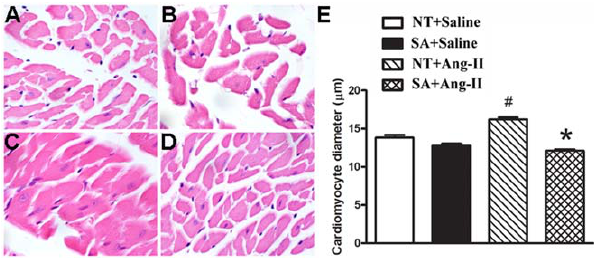
Figure 2. Brain-targeted ACE2 over expression prevents the increase in cardiomyocyte diameters following Ang II infusion. Mice were anesthetized and hearts were processed for H&E staining at the end of 2 weeks Ang II or saline infusion. The average cardiomyocyte diameters were quantized by using Image-Pro Plus software. The cardiomyocyte diameters were not different between NT ( A ) and SA ( B ) mice following 2 weeks of saline infusion (P . 0.05). Ang II infusion significantly increased the cardiomyocyte diameters in NT ( C ) compared to saline infusion (P , 0.05). However, it was smaller in SA ( D ) compared to NT mice at the end of 2 weeks Ang II infusion (P , 0.05). N=5/group. Statistical significance: * P , 0.05 vs. NT with the same treatment; # P , 0.05 vs. saline with the same